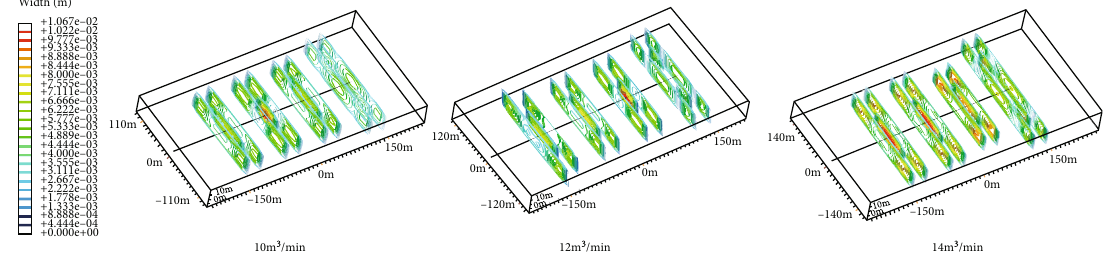
Figure 7: Fracture geometries of di ff erent fracturing fl uid injection rates per stage.